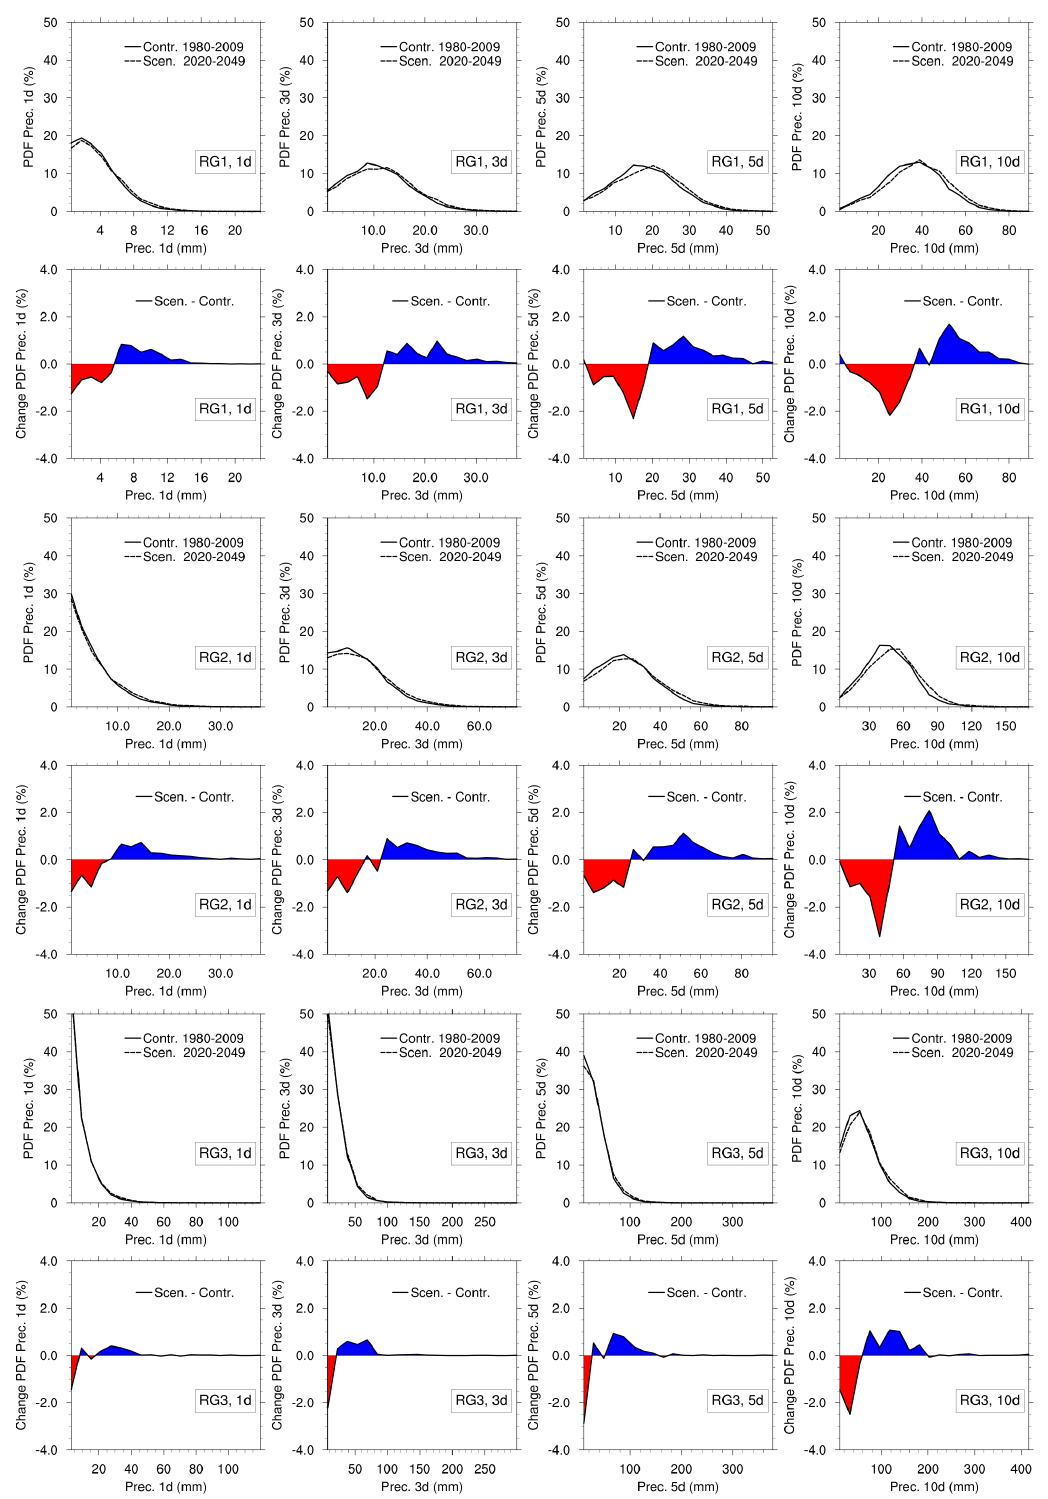
Figure 20. Probability density functions (PDF) of precipitation intensities for intervals of 1, 3, 5, and 10 days (moving window, from left to right) and the changes in the PDFs between the scenario (2020–2049) and control run (1980–2009) for RG1 (first and second row), RG2 (third and fourth row), and RG3 (fifth and last row). The bin sizes for the PDFs are for RG1: 1.2, 1.9, 2.7, and 4.6 mm, for RG2: 1.9, 3.8, 4.9, and 8.7 mm, and for RG3: 6.1, 15.3, 19.3, and 21.4